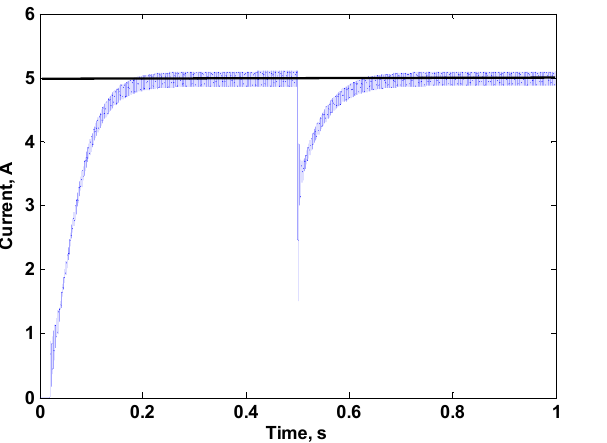
Figure 26. Charging current at a reference current of 5 A during the reduction of the first-stage source